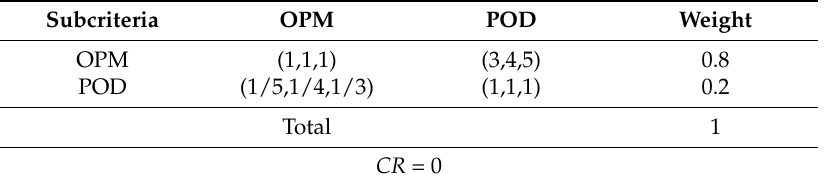
Table A9. Comparison matrix for COC.